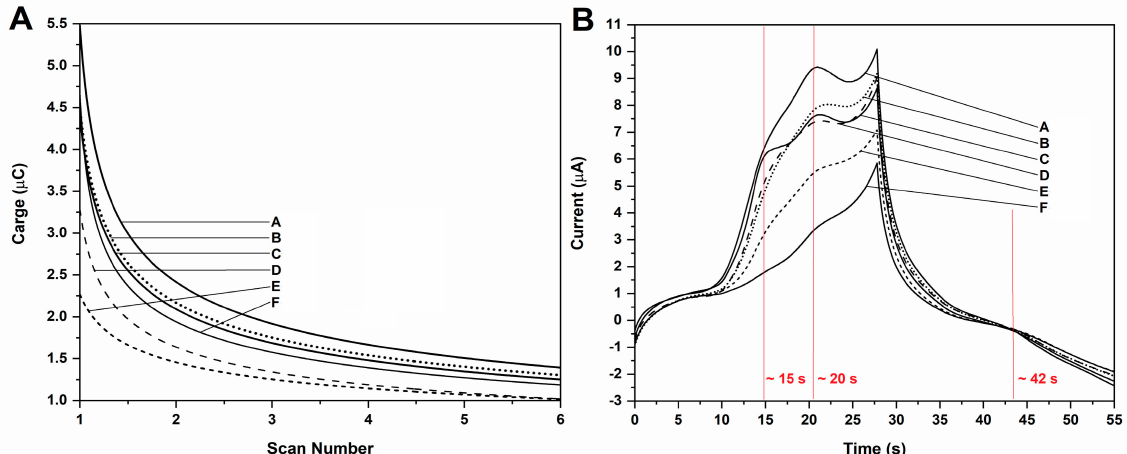
Figure 2. ( A ) Integrated charge of the chronocoulograms fitted according to Belehradek function (all fittings above r 2 0.98). ( B ) Chronoamperograms extracted from CV scans. The samples are therein indicated (A to F). The time associated with the visualization of each faradaic process is highlighted on the chronoamperogram with a red color.